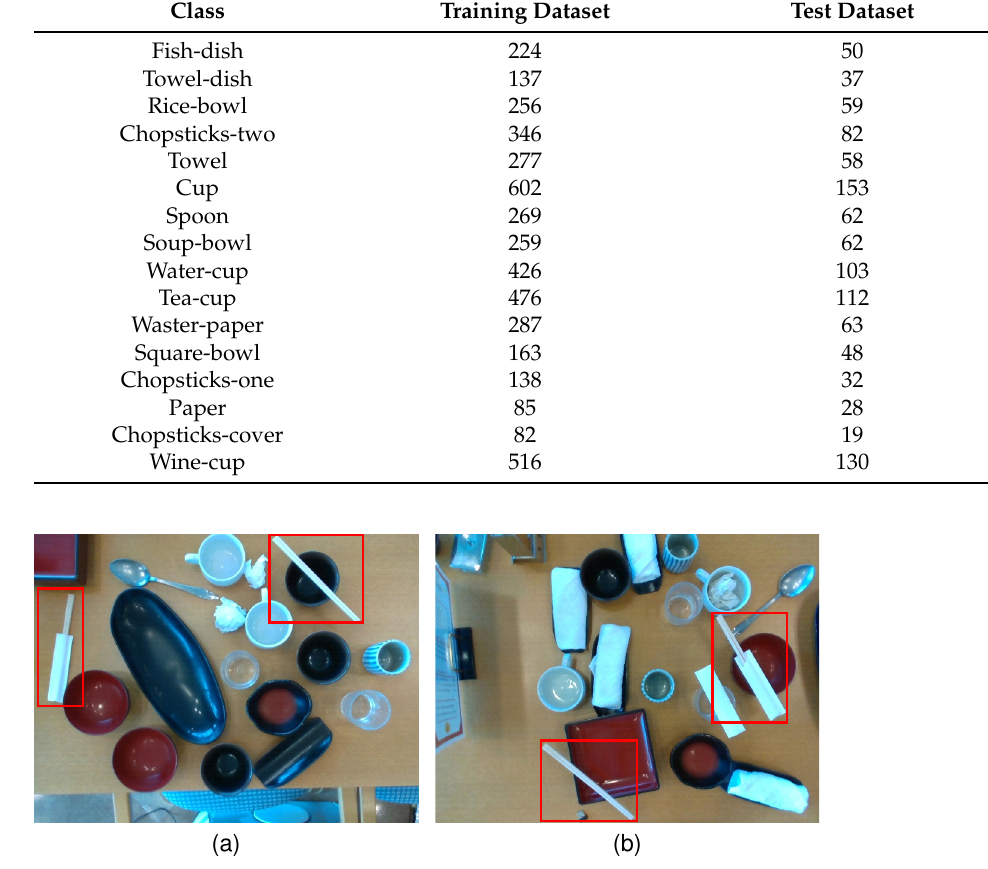
Figure 8. Examples of Chopsticks-two in the training dataset. ( a ) first example, ( b ) second